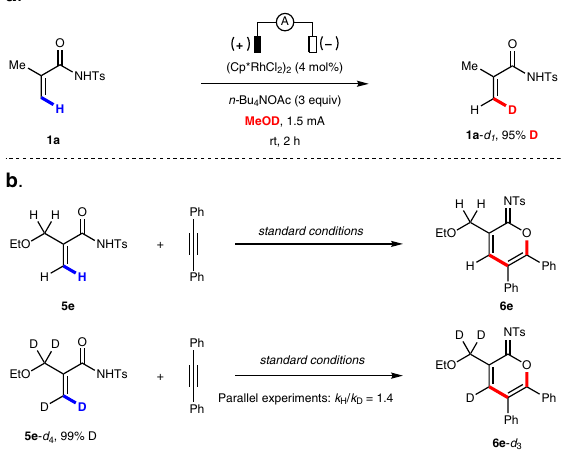
Fig. 4 H/D exchange experiment and kinetic isotopic effect experiments. a H/D exchange experiment. b Kinetic isotopic effect experiments.